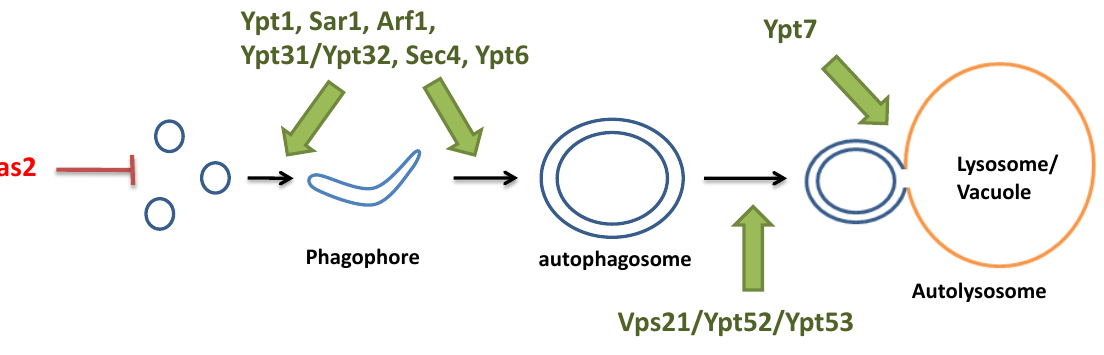
Figure 6. Summary of the known functions of the monomeric GTP-binding proteins in autophagy. (1) Ras2 inhibits the initiation of autophagy; (2) Ypt1, Sar1, Arf1, Ypt31/Ypt32, Sec4, and Ypt6 are required for phagophore formation and expansion to form the autophagosome; (3) Vps21/Ypt52/Ypt53 are required for the efficient localization of Atg8 to the vacuole; and (4) Ypt7 is required for the fusion between autophagosome and